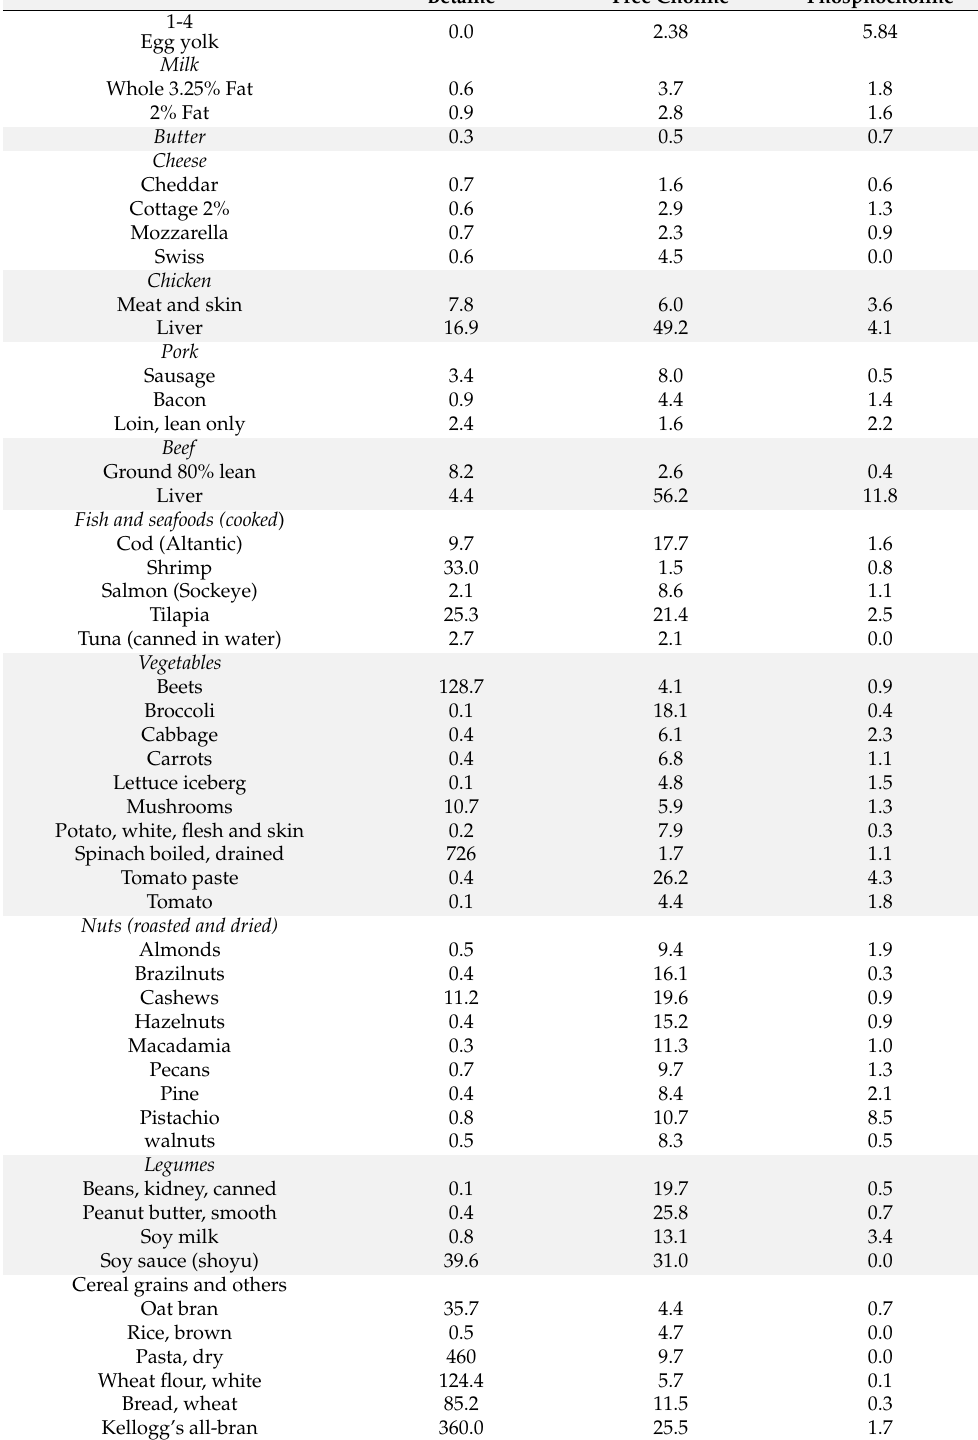
Table 1. Betaine, phosphocholine and free choline raw food contents in g for 100 g